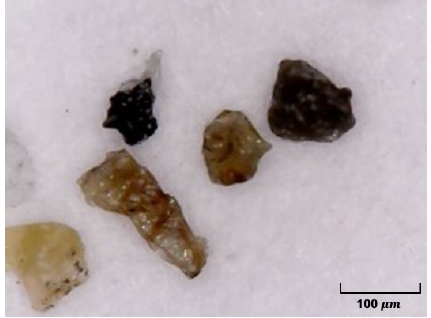
Figure 10. A stereo-microscope image of middling particles from a fine shaking table in a Turkish chromite beneficiation plant at 180 + 125 μ m size fraction [107].